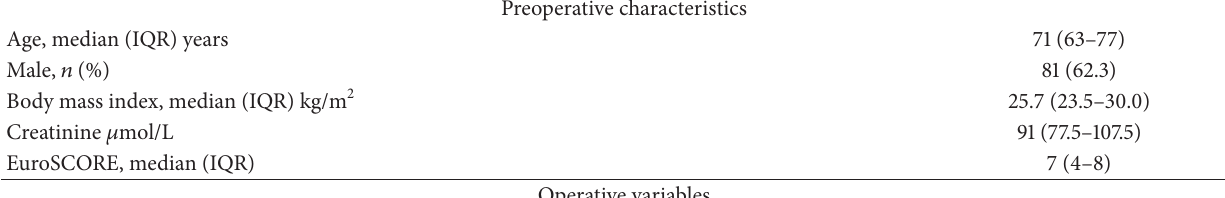
Table 1: The main clinical and biochemical characteristics, operative variables, and postoperative outcomes of study patients a . Preoperative characteristics